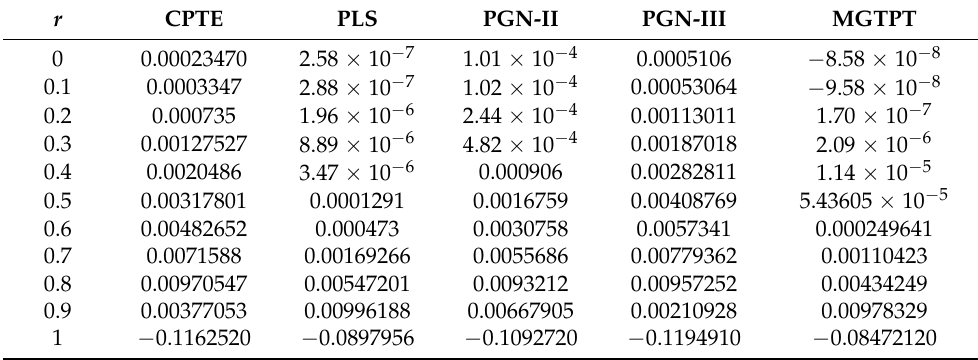
Table 2. The displacement variation u under photothermal models.